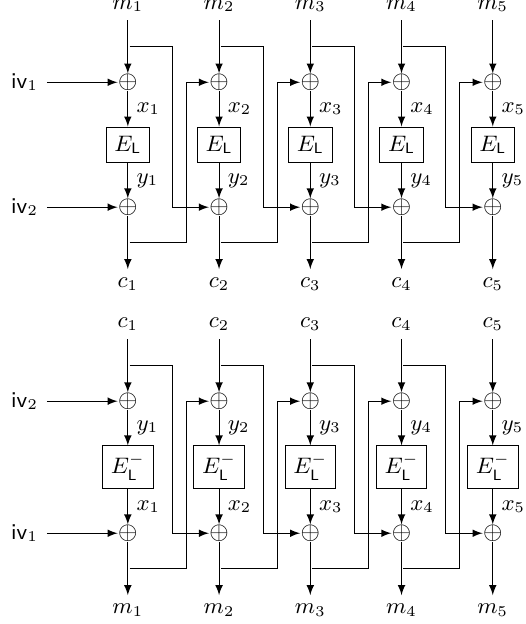
Figure 3.4: IGE encryption ( top ) and decryption ( bottom )